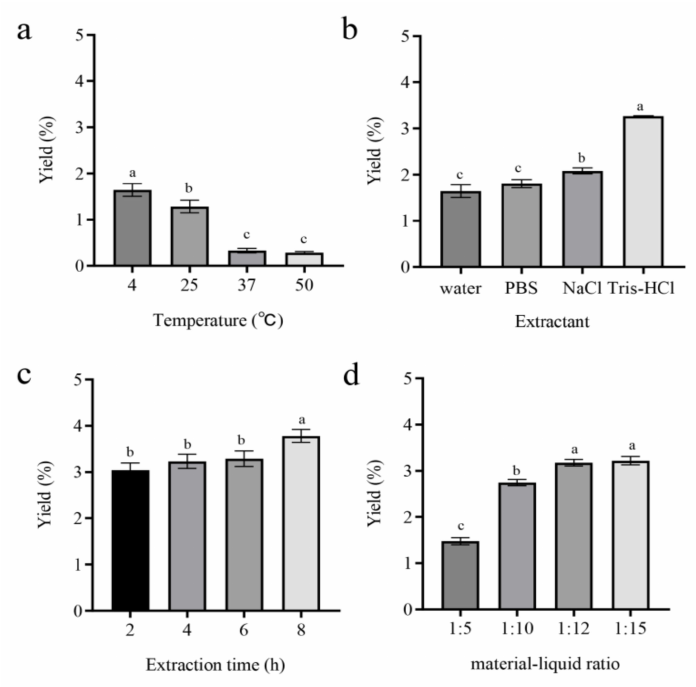
Figure 1. Effect of various factors on extraction of A. cinnamome a proteins (ACPs): ( a ) Temperature; ( b ) extractant; ( c ) extraction time; ( d ) material/liquid ratio. Differing letters above bars indicate significant ( p < 0.05) differences according to Tukey’s multiple comparisons